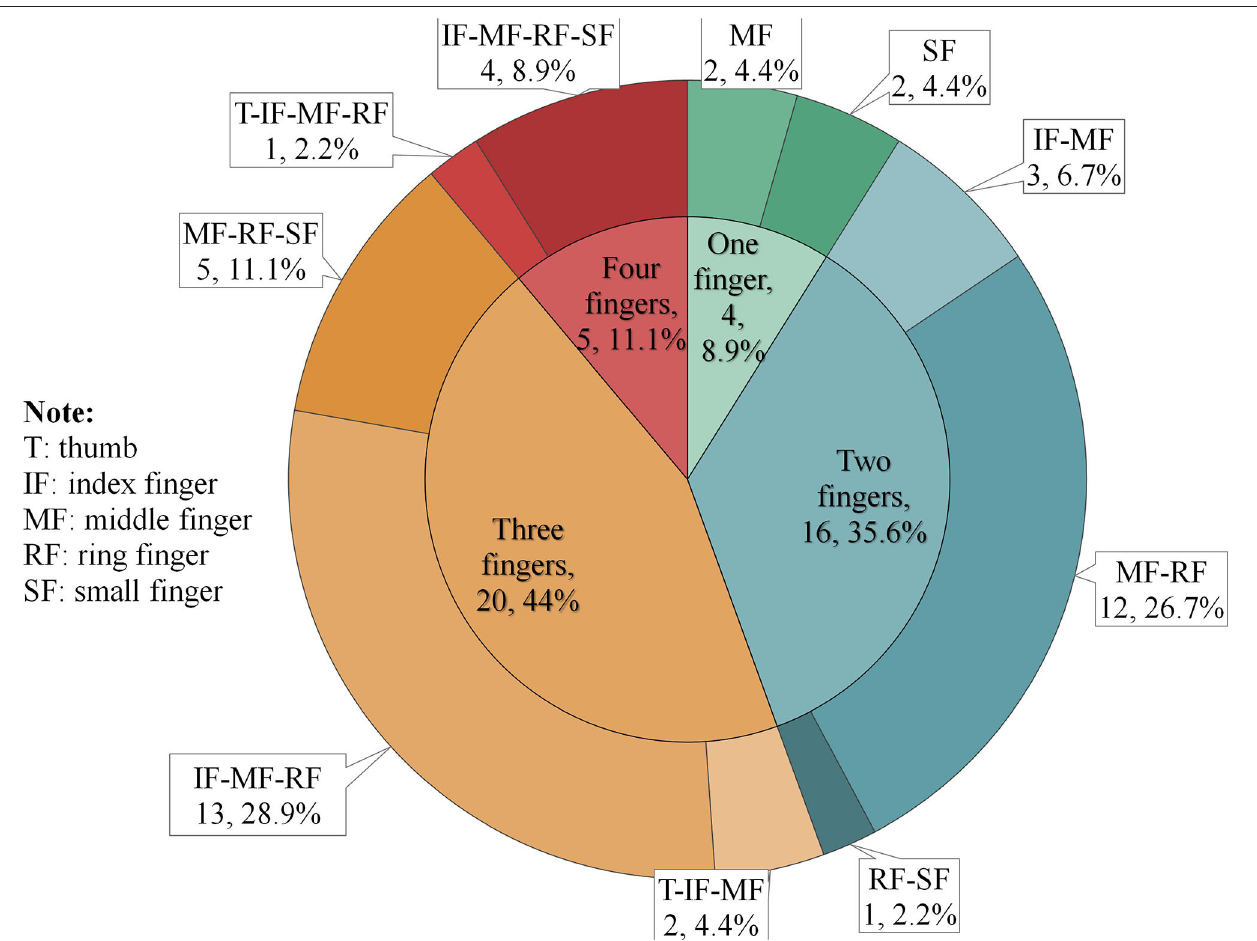
FIGURE 1 | Injury patterns of the involved 116 fingers. The inner circle of the pie chart represents the number of involved fingers in each injured hand. The outer circle of the pie chart shows how these finger injuries are